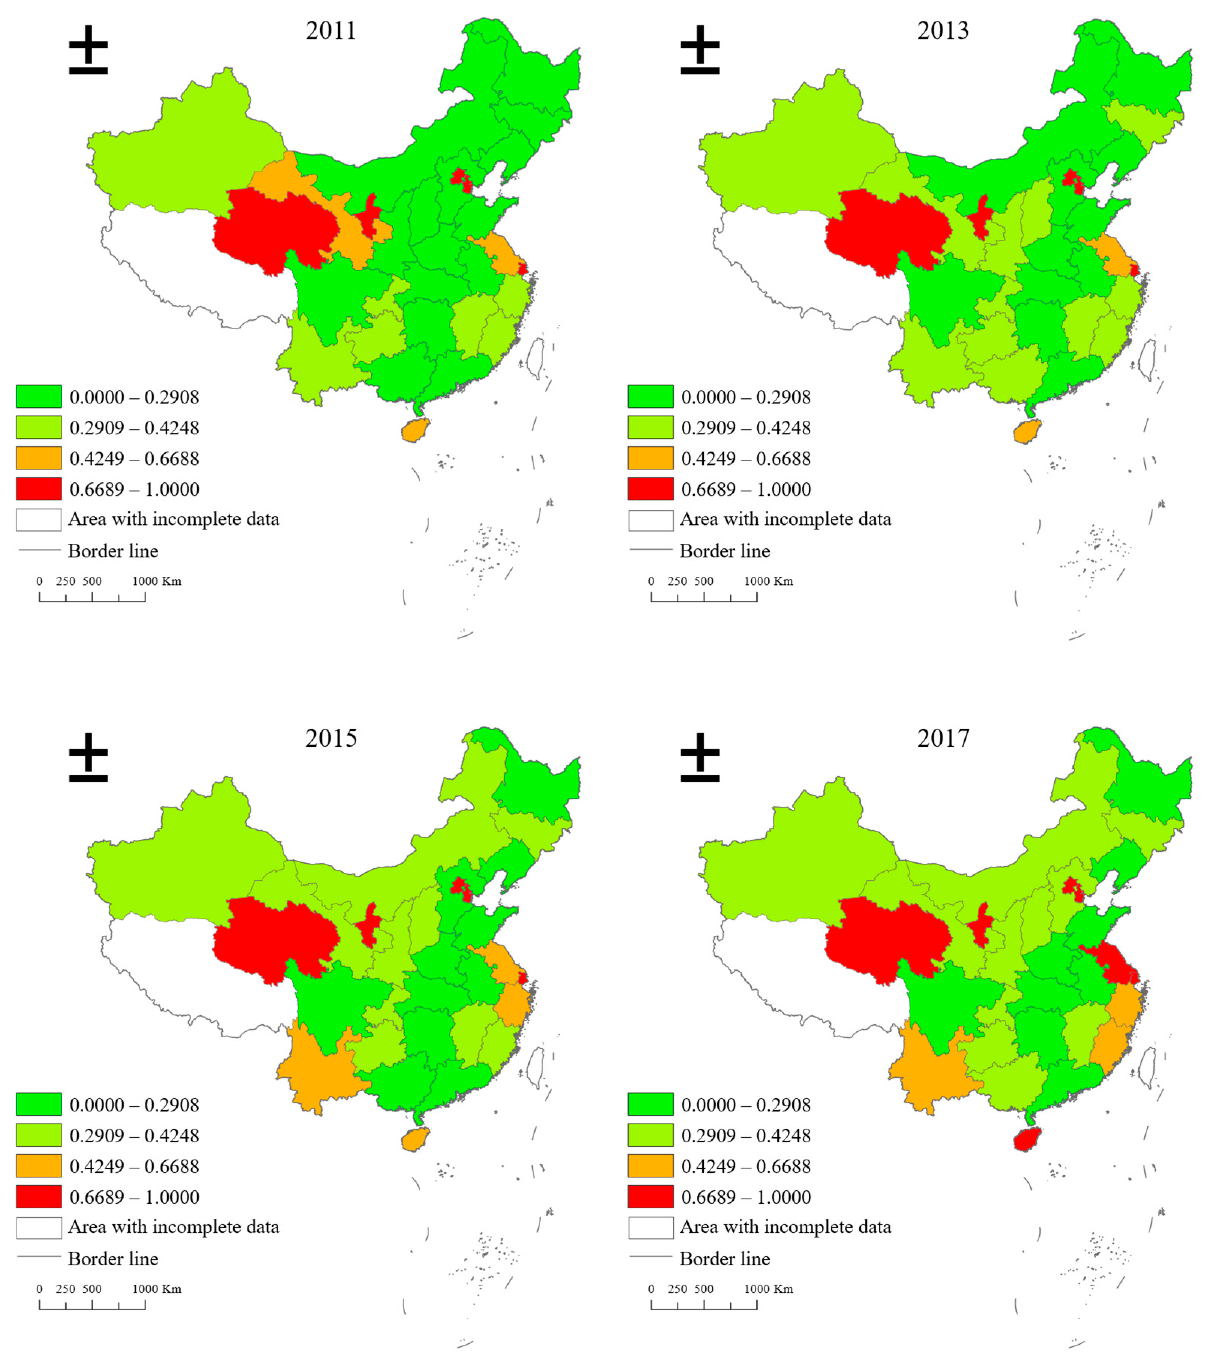
Figure 2. Spatial and temporal distribution and evolution trend of SLUE in China. Furthermore, Figure 3 plots the dynamic density distribution variations of the SLUE index for the whole country and the four regions in 2011, 2014, and 2017. This is used to track the changes in SLUE over time. Nationally, SLUE values were mainly concentrated between 0.2 and 0.4. In addition, the density function curve has the characteristics of moving to the right, with the left peak falling and the right peak moving upward. This indicates that the average value of national SLUE trended upward from 2011 to 2017. At the same time, SLUE in the four regions showed a trend of improvement. There are also great development differences, both between regions and within regions. The analysis results are consistent with the